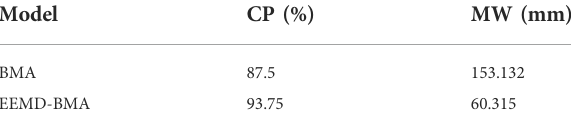
TABLE 5 Performances of BMA and